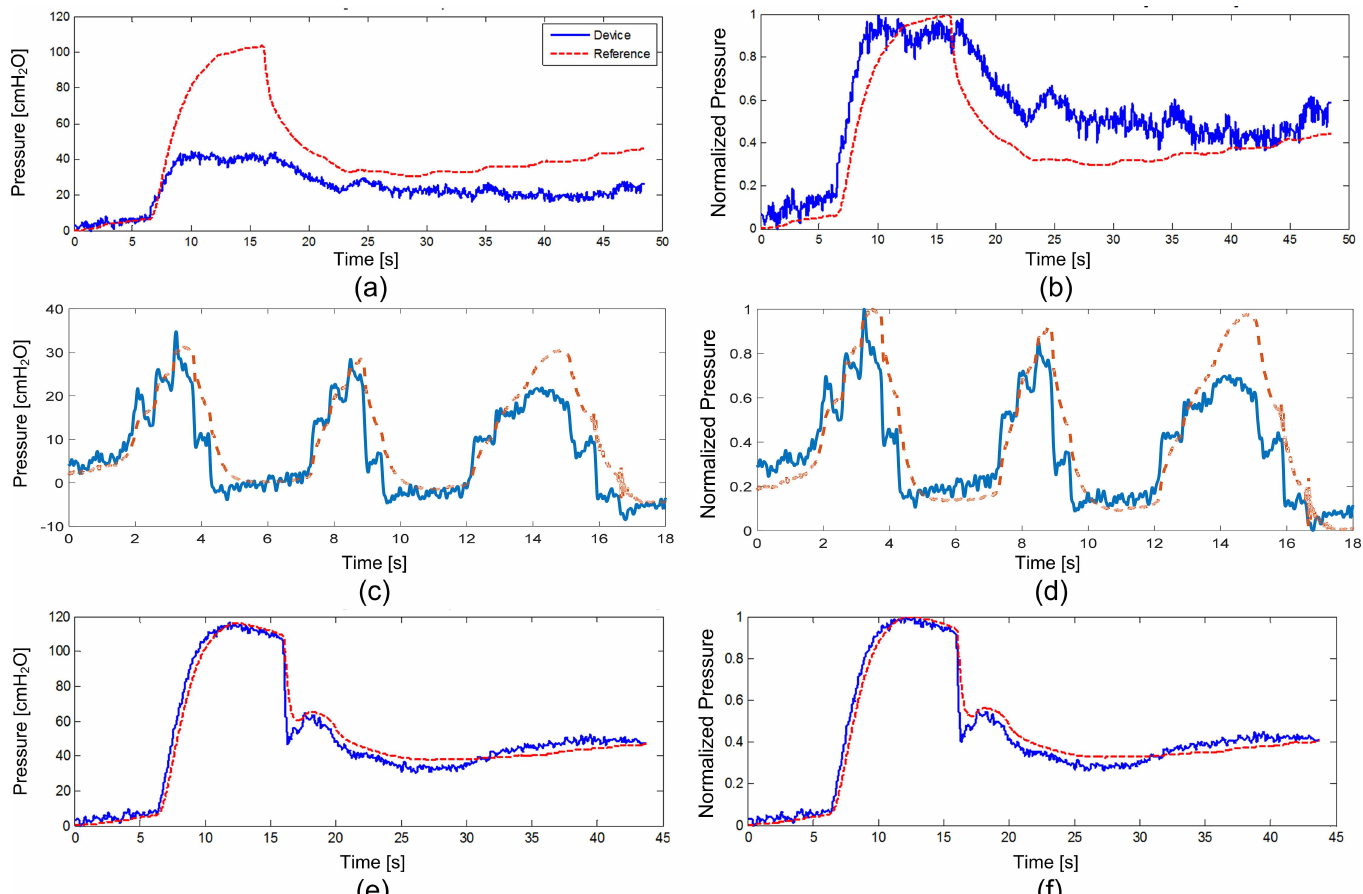
Fig 5. Example Recordings in the Nonsurvival Canine. Examplesof device (solid blue line) and reference (dashedred line) recordings of electrically- inducedisometric contractions in canine (a) as-recordedand (b) normalized recordingswith the device in the submucosal location.Manual bladder compressions from the submucosalsensor (c) as-recordedand (d) normalized were correlatedwith reference lumen pressure but showedrate-change variation. Lumenpressure (e) as-recorded and (f) normalized recordingswith the device in the bladderlumen showedgood agreementwith the